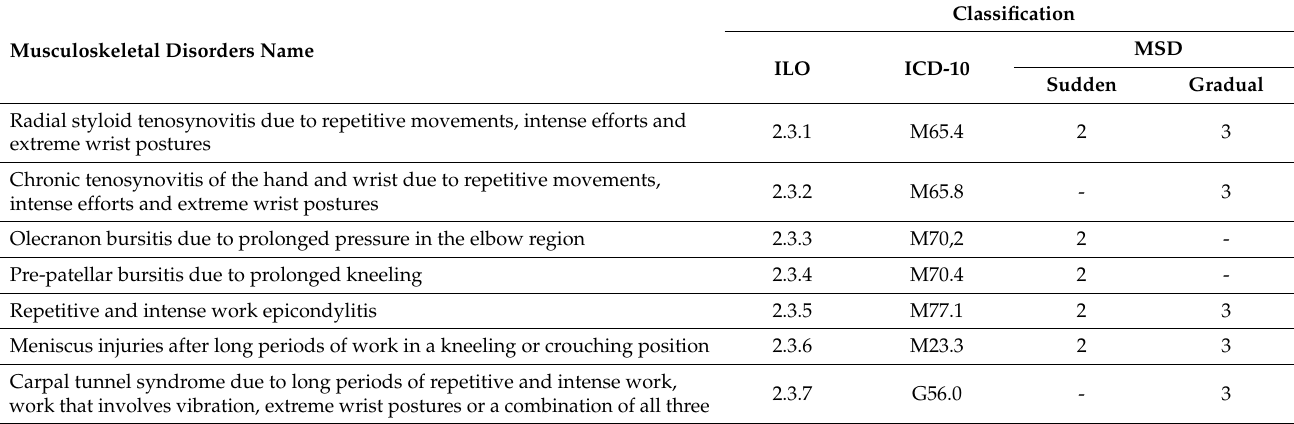
Table 7. Application of different types of classification to MSD recognised by